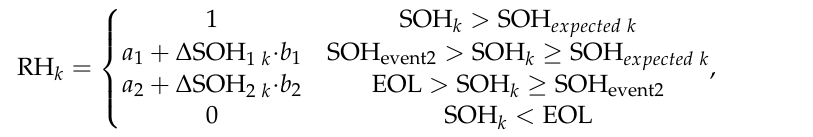
Figure 1. Proposed color map of the remaining warranty.